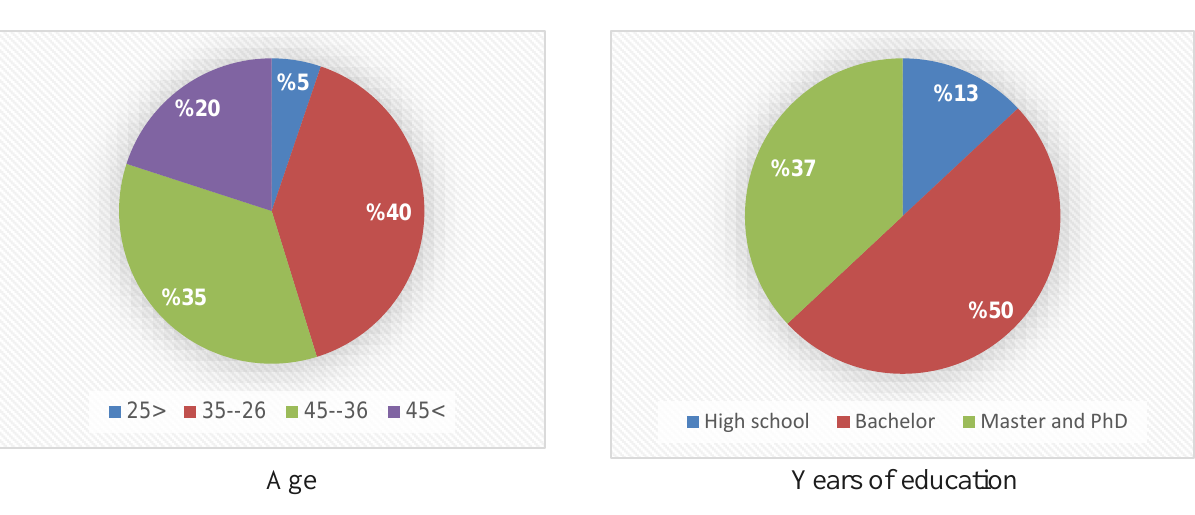
Fig. 1. Personal characteristics of the